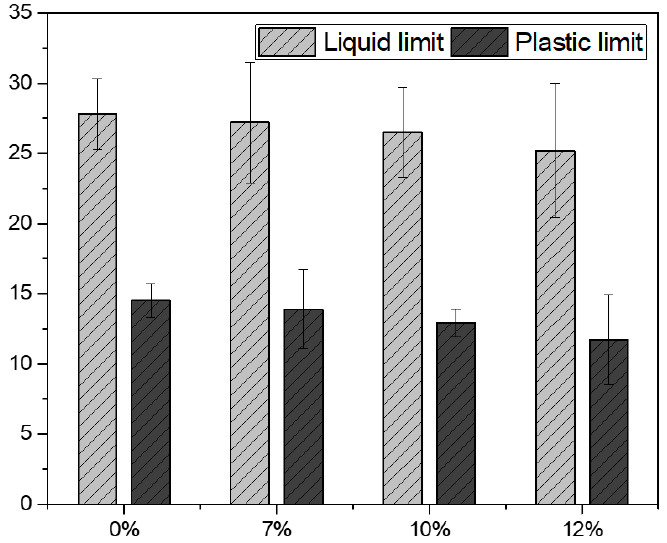
Figure 7. Liquid limit (%) and plastic limit (%) values of soil samples.